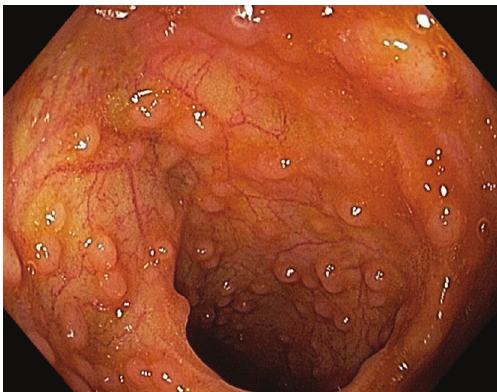
Figure 1: Peyer’s patches in the distal ileum. PPs seen in a 20-years- old man during ileocolonoscopy. Note that PPs form a lymphoid ring in the distal